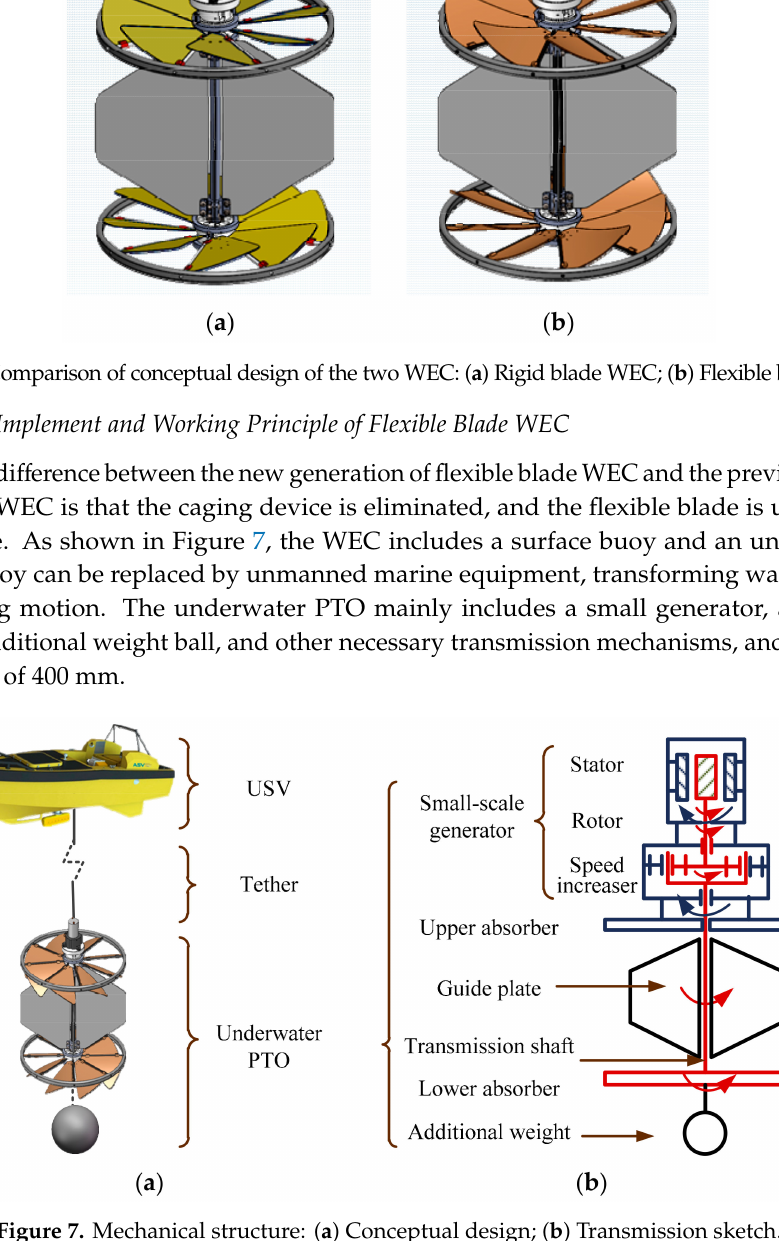
Figure 7. Mechanical structure: ( a ) Conceptual design; ( b ) Transmission